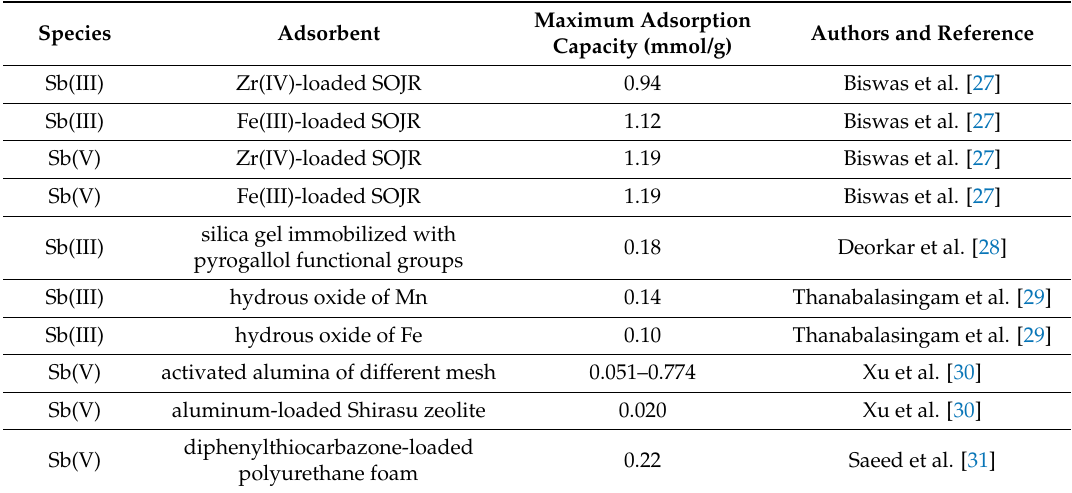
Table 2. Maximum Sb (V and III) adsorption capacities of metal-loaded SOJR gels and other adsorbents.